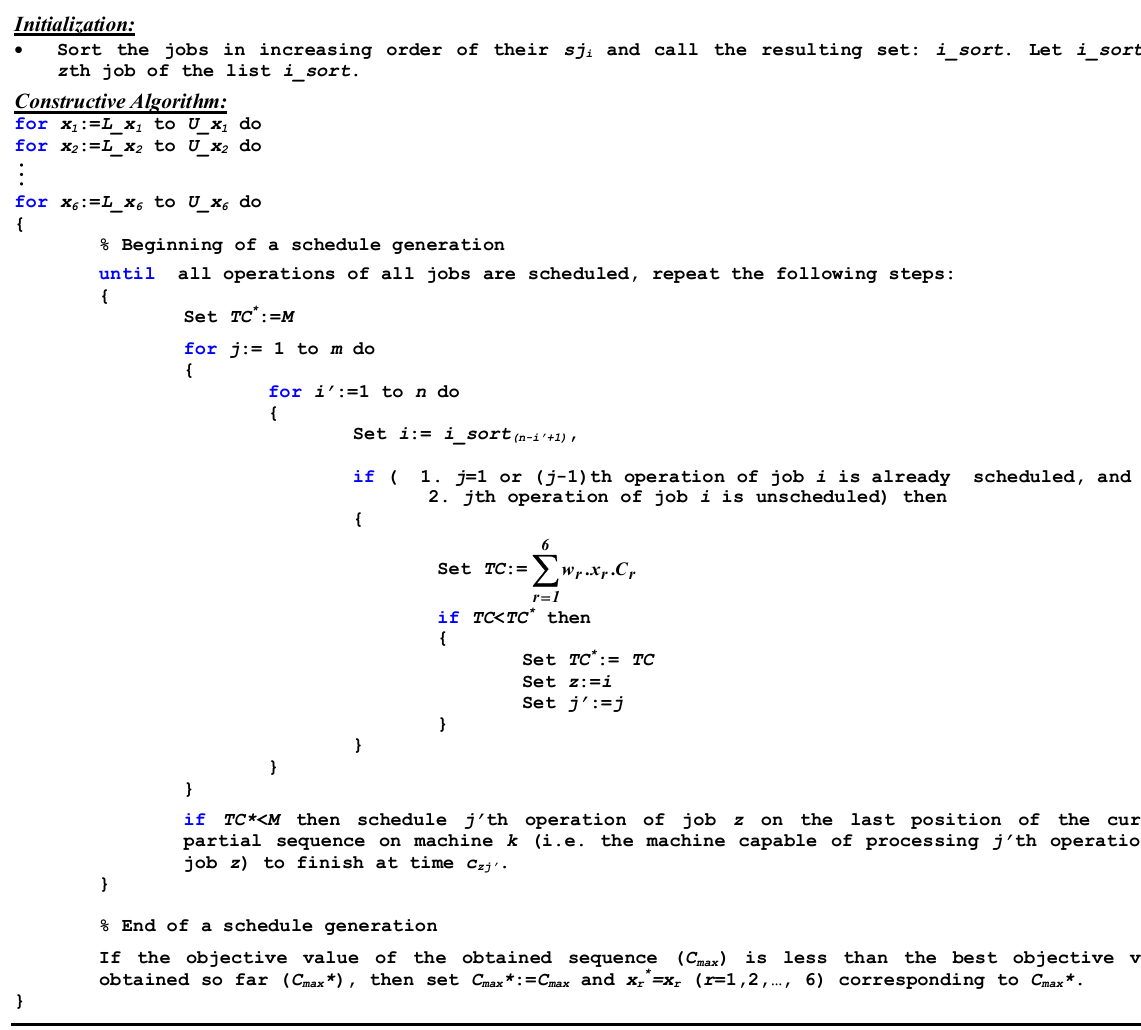
Fig. 2. Pseudocode of the proposed heuristic method